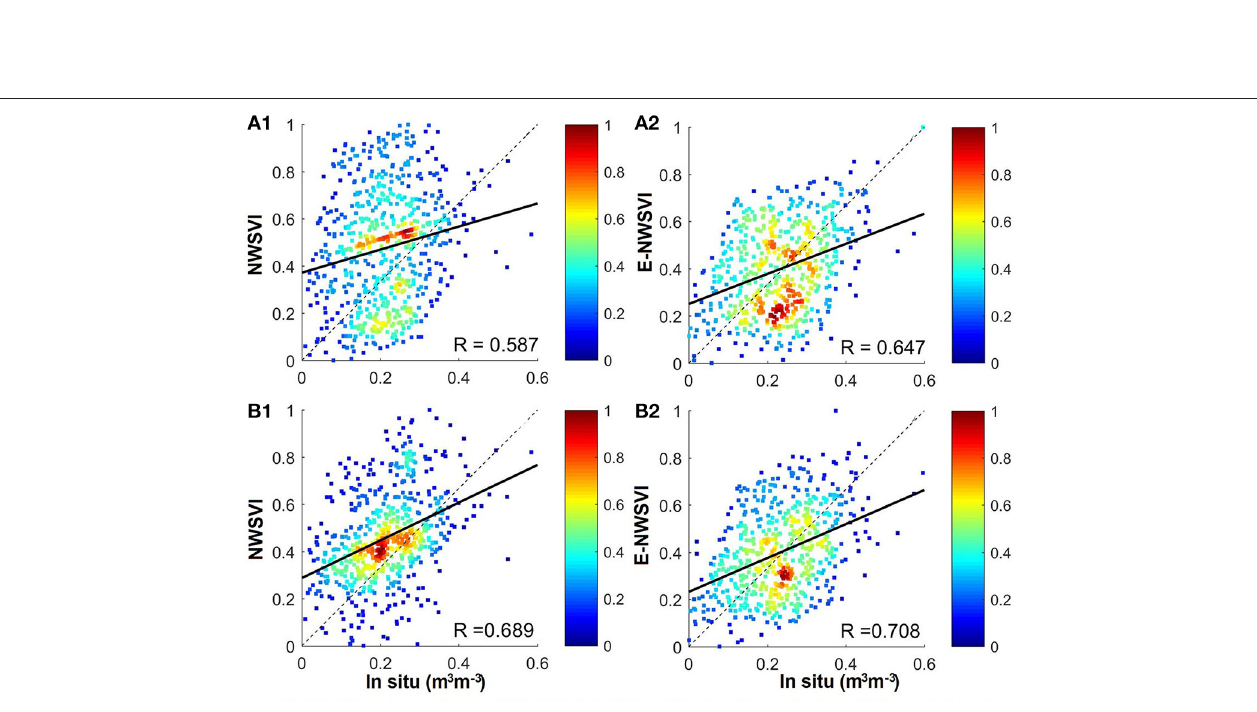
Frontiers in Big Data |